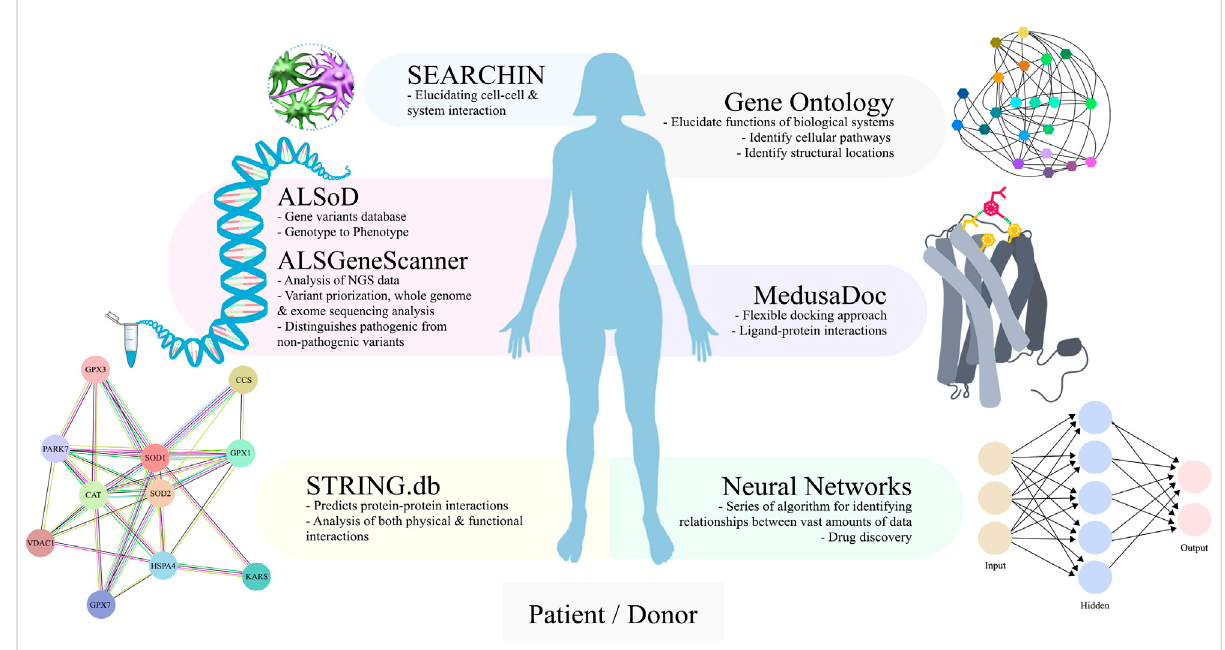
FIGURE 5 An overview of bioinformatics and computational tools that can be paired to iPSC-ALS research. For ALS genetics, bioinformatics repositories provide automated analysis for genotype to phenotype association studies (ALSoD) and interpretation of complex genetics data (ALSGeneScanner). For iPSC-ALS, protein-protein interactions can be mapped with subsequent pathway analysis (STRING.db). Scaling up to multicellular systems requiresincreasedanalysistechniquesthatareavailable(SEARCHIN).ForiPSC-ALSdrugdiscovery,smallmoleculetargetstoproteinsofinterest can be identi fi ed (Neural Networks) and docked with the ligand